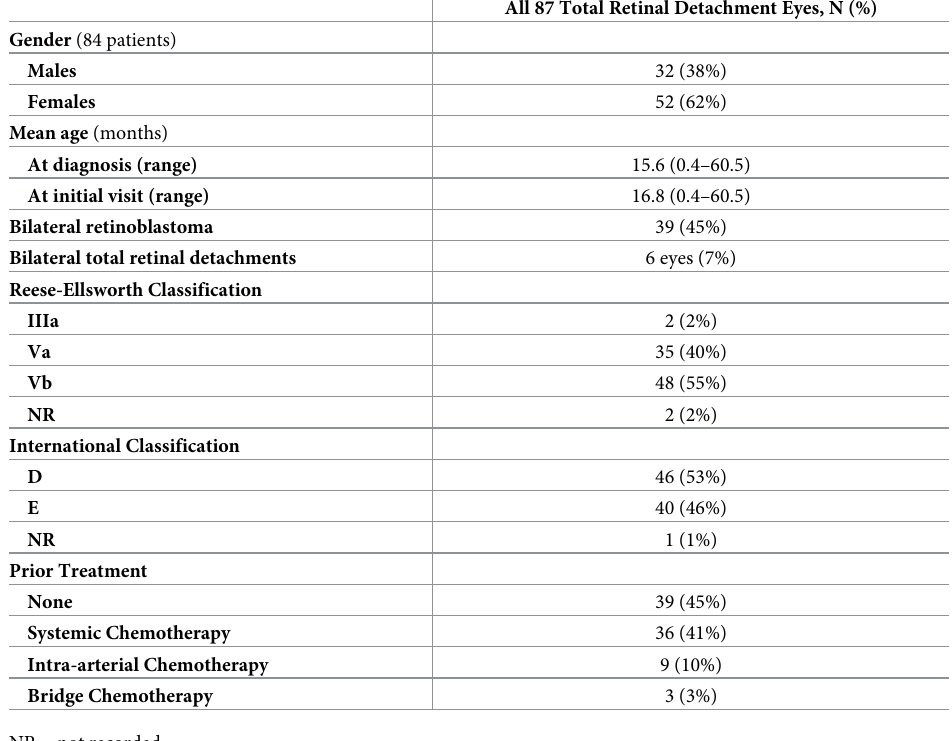
Table 1. Clinical characteristics of study